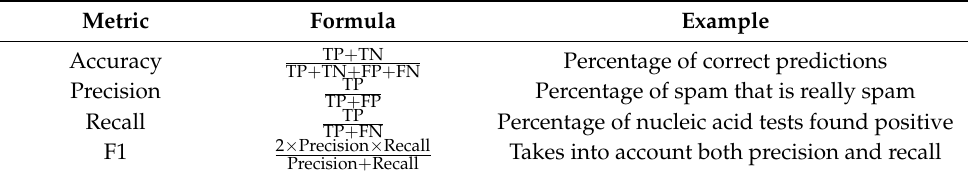
Table 7. Confusion Matrix Performance